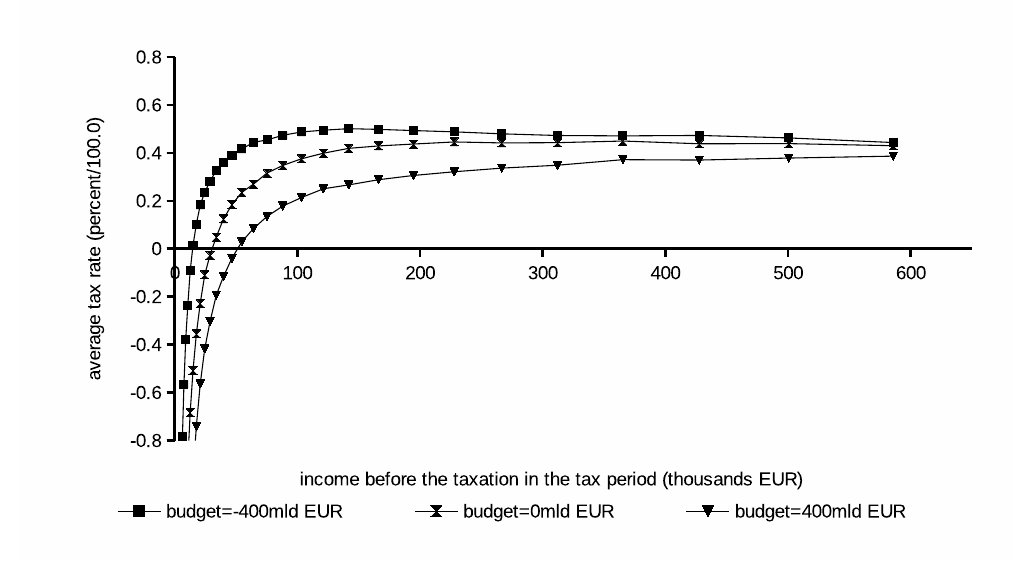
Figure 5. Average income tax rates for different B values (budget flow). Table 3. Simulation results for different B values (budget